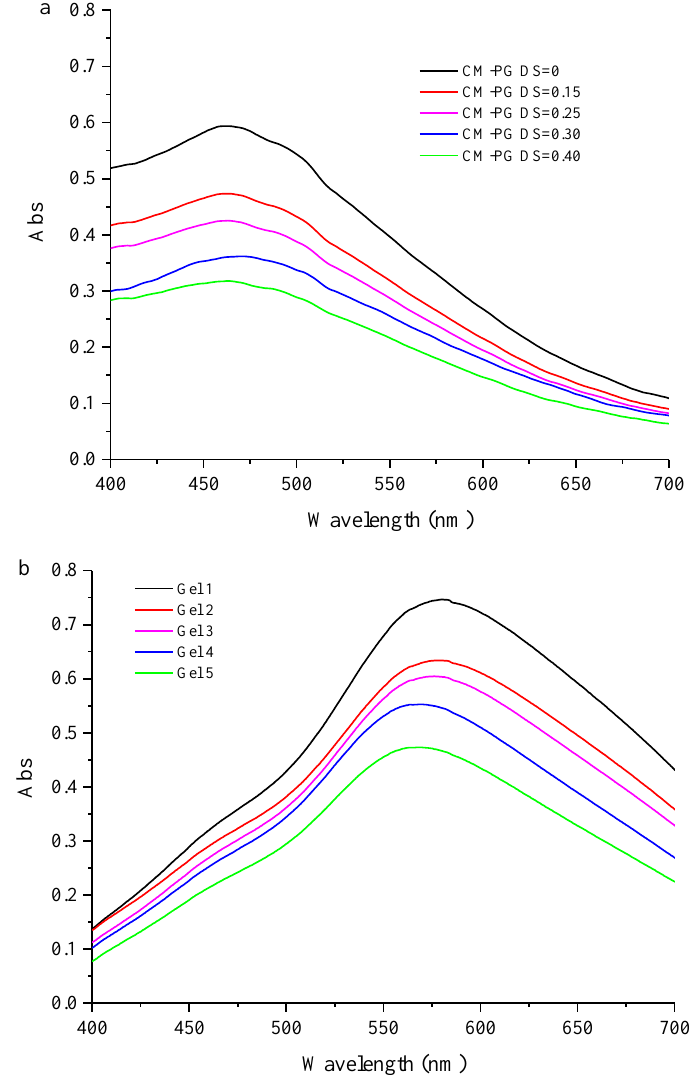
Figure 1. Iodine absorption spectra of ( a ) CM-PG and ( b ) hydrogels.